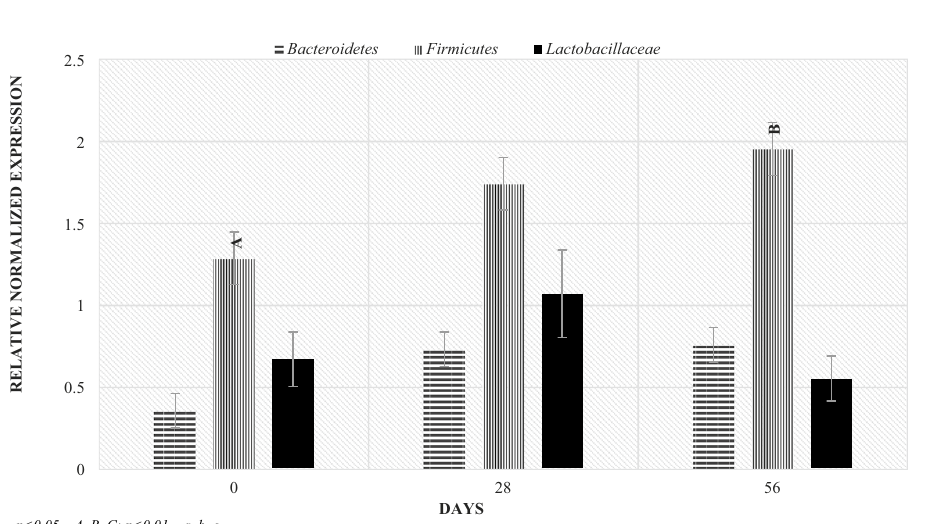
Figure 6. Level of RNE in lamb feces. p < 0.05—A, B, C; p < 0.01—a, b, c.